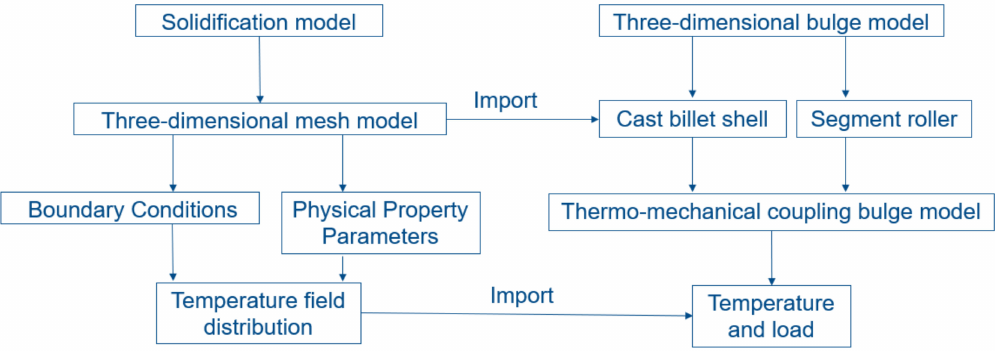
Figure 4. The relationship between the solidification model and the slab deformation model.